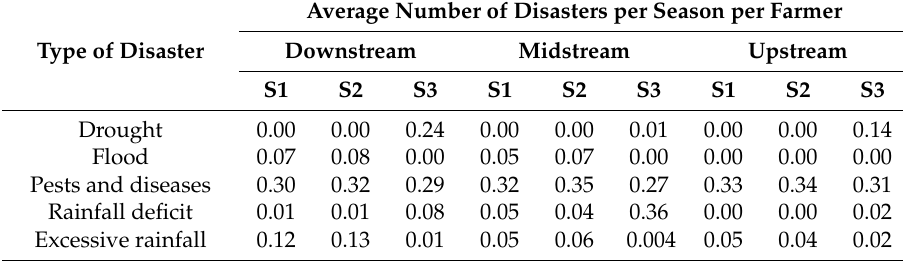
Table 3. Average number of disasters.